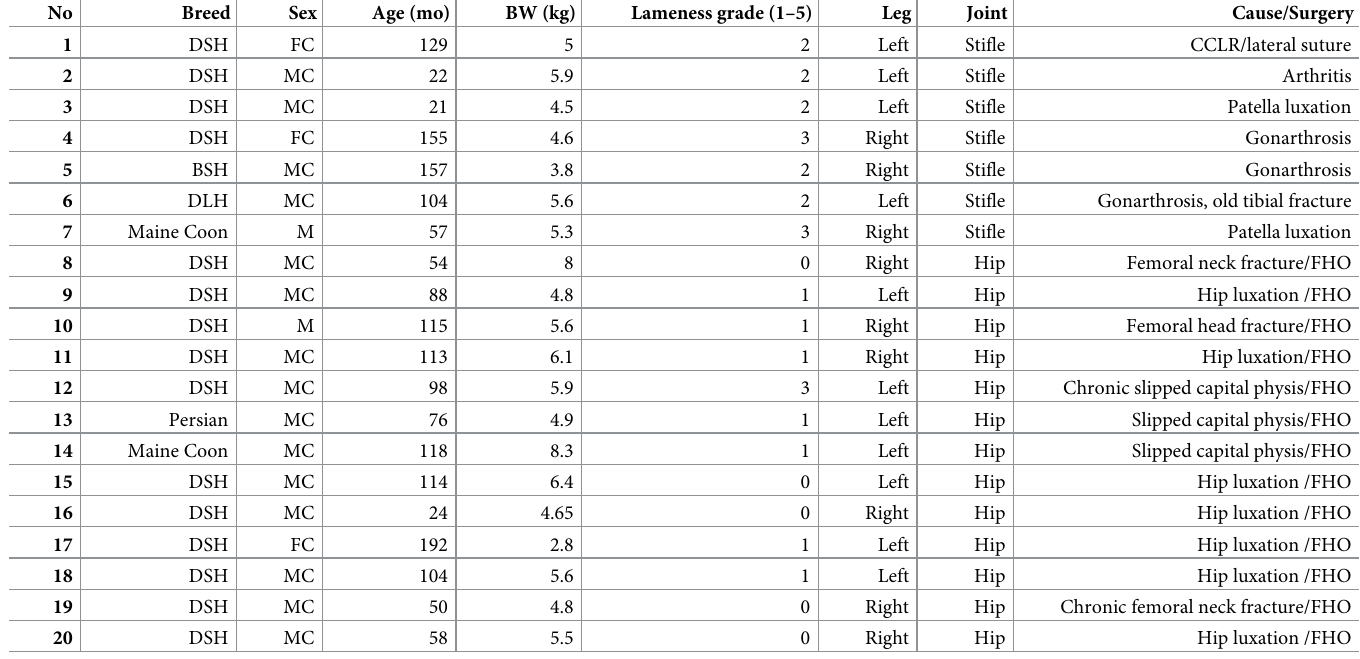
Table 1. Characteristics of the 20 lame cats in this study.